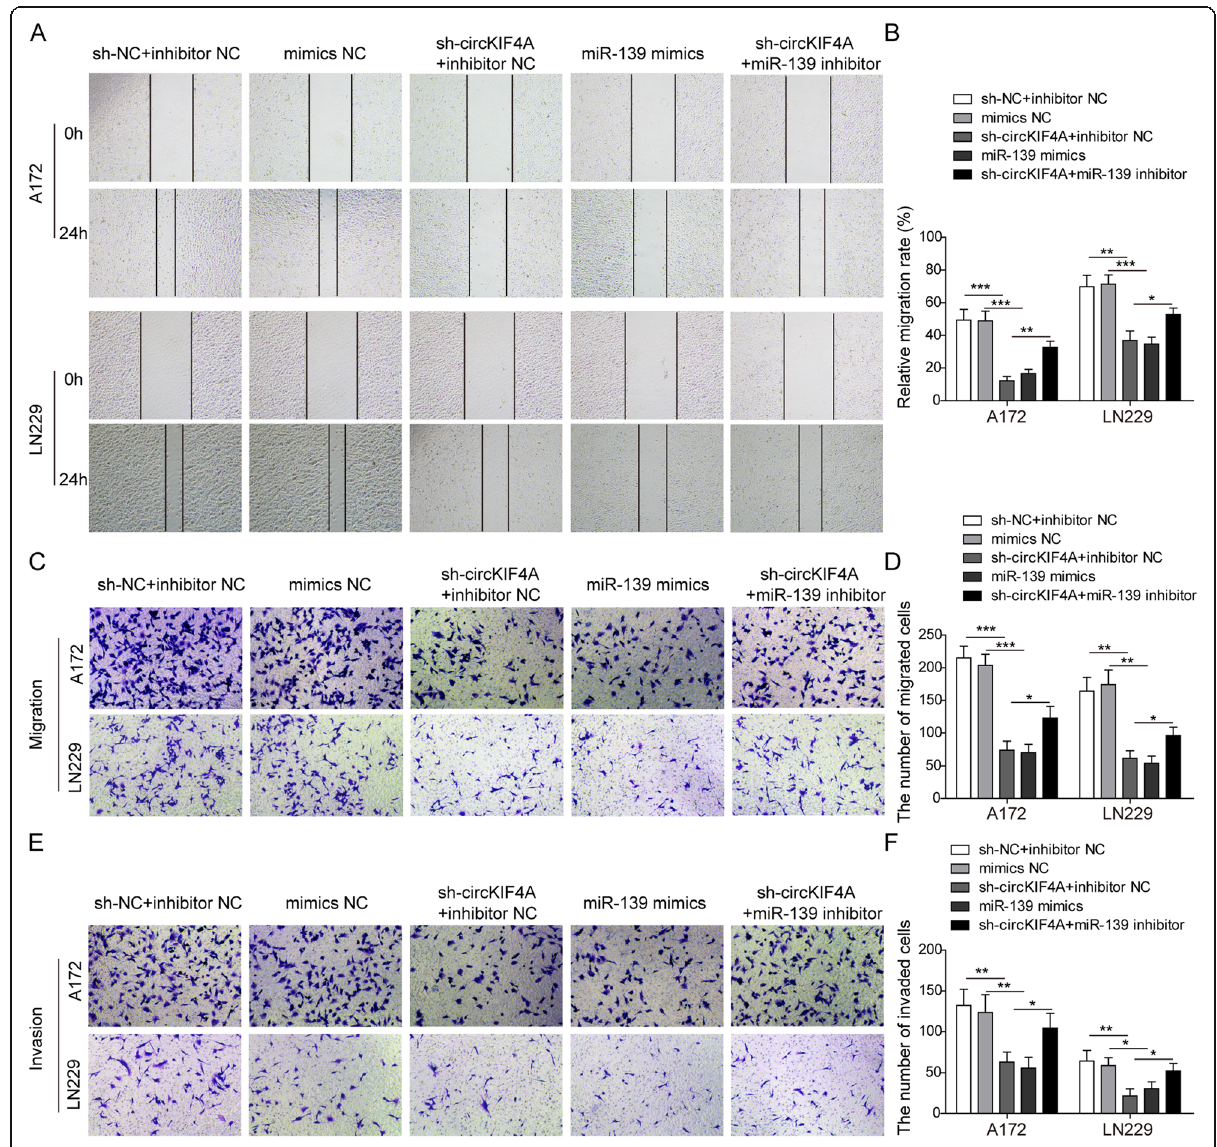
Fig. 4 circKIF4A knockdown inhibited migration and invasion via miR-139-3p in in A172 and LN229 cells. After transfecting cells with sh-circKIF4A, miR-139-3p mimics or miR-139-3p inhibitors, a the migration of A172 and LN229 cells was determined by wound healing assay. b Quantitative analysis of cell migration rate. c The migration of A172 and LN229 cells was determined by transwell assay. d Quantitative analysis of the migration cell number. e The invasion of A172 and LN229 cells was determined by transwell assay. f Quantitative analysis of the invasion cell number. * p < 0.05, ** p < 0.01, *** p <